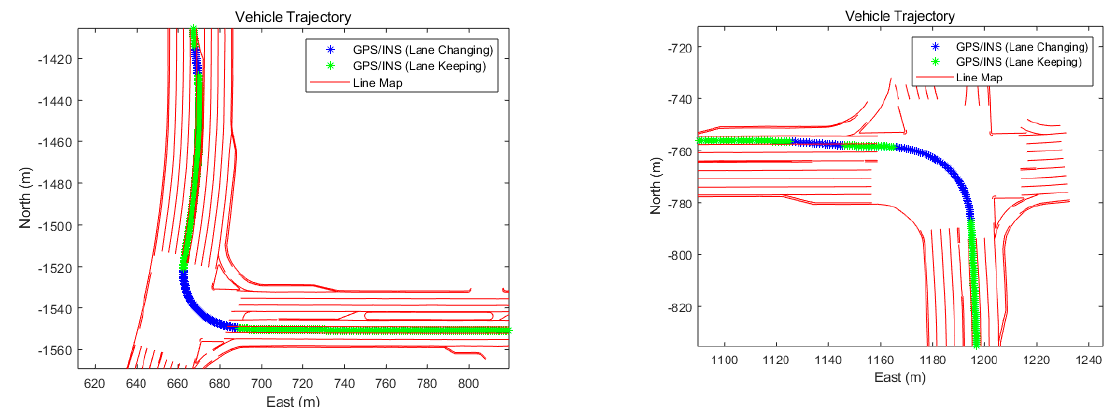
Figure 11. Result of dividing the vehicle trajectory into lane change and lane keeping sections.